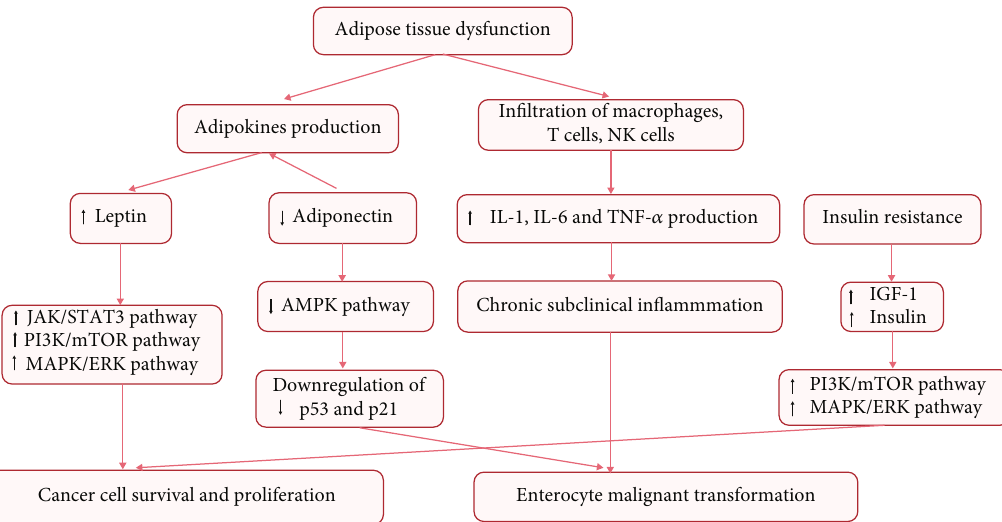
Figure 4: E ff ects of obesity and adipose tissue dysfunction on colorectal carcinogenesis. JAK: Janus kinase; STAT3: signal transducer and activator of transcription 3; PI3K: phosphatidylinositol 3-kinase; mTOR: mammalian target of rapamycin; MAPK: mitogen-activated protein kinase; ERK: extracellular signal-regulated kinase; AMPK: adenosine monophosphate-activated protein kinase; IL-1 β : interleukin- 1 β ; IL-6: interleukin-6; TNF- α : tumor necrosis factor- α .